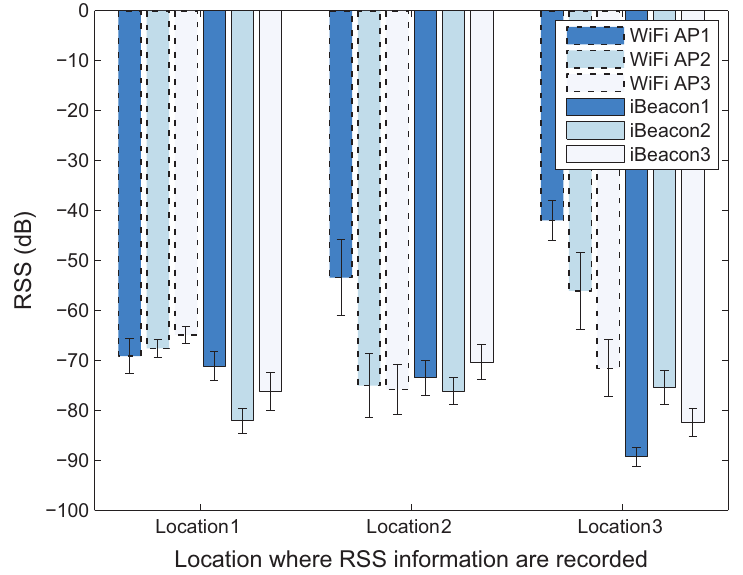
Figure 4. RSS comparison among adjacent